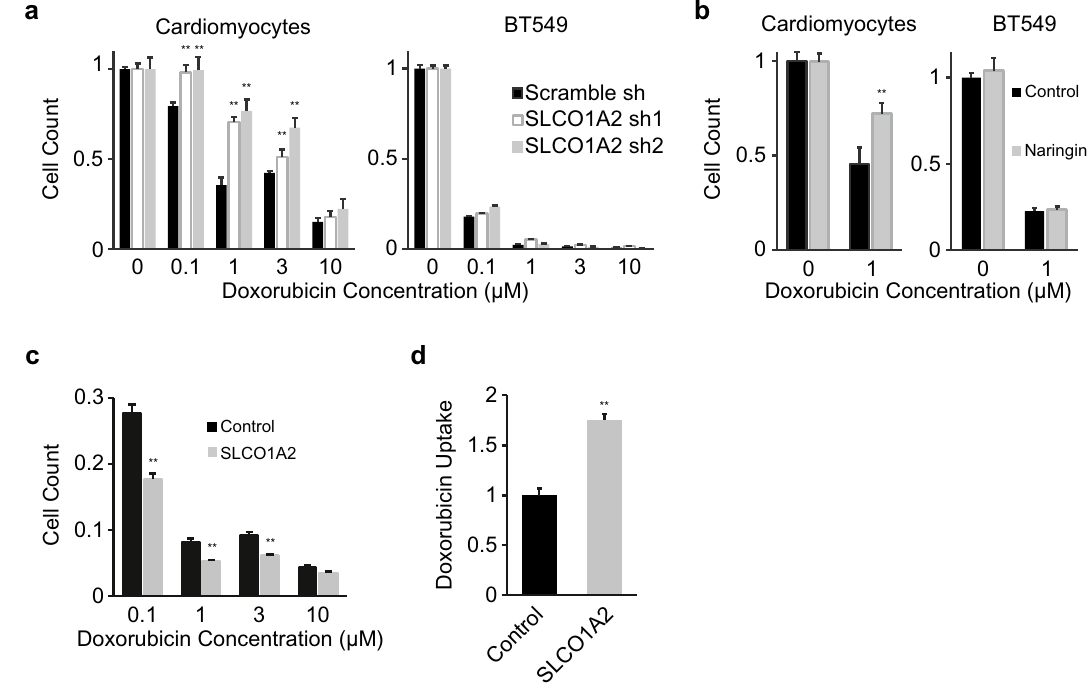
Figure 4. SLCO1A2 mediates doxorubicin-toxicity in iPS derived cardiomyocytes. ( a ) Dose response for doxorubicin toxicity in cells expressing control Scramble shRNA, or two sequence independent shRNAs targeting SLCO1A2 in iPS derived cardiomyocytes or BT549 breast cancer cells (**: p < 0.01 vs scramble shRNA). ( b ) Doxorubicin-toxicity in cells treated with the SLCO1A2 inhibitor naringin in iPS derived cardiomyocytes or BT549 cancer cells (**: p < 0.01). ( c ) Doxorubicin toxicity (n = 8 per condition) and ( d ) uptake (n = 3 per condition) in cells over-expressing SLCO1A2 (**: p < 0.01). ( a – d ) p from student’s